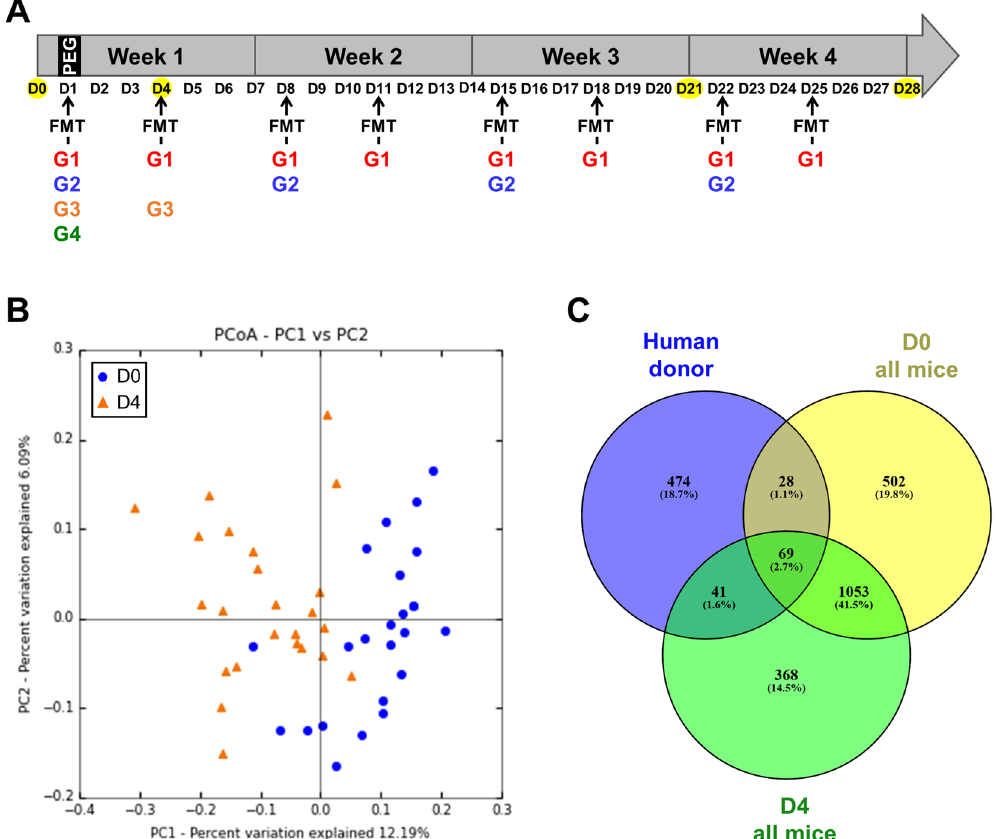
Figure 3. Modification of the murine microbiota following human FMT. ( A ) Timeline showing the human intestinal microbiota inoculation scheme in conventional mice. Arrows indicate each microbiota inoculation by oral gavage and yellow circles indicate collection of feces samples for all mice of the protocol. ( B ) PCoA plot showing the unweighted UniFrac distance (p < 0.001). Blue circles correspond to the microbiota at D0 and orange triangles to the microbiota at D4. ( C ) Venn diagram based on OTUs distribution between the human donor and all the mice at D0 or